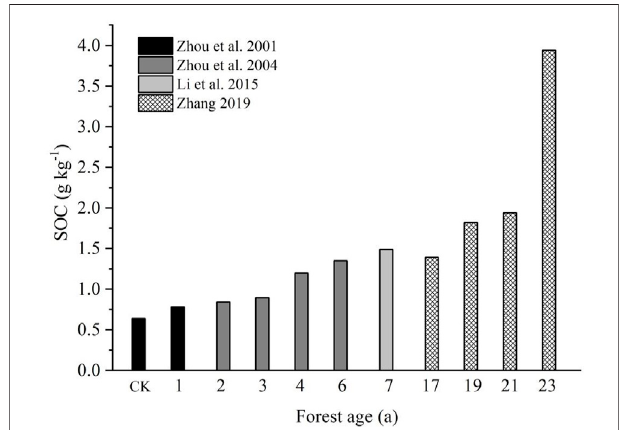
FIGURE 6 | SOC content at different forest ages (Zhou and Xu. 2004; Zhou et al., 2006; Li et al., 2015; Zhang et al., 2017).